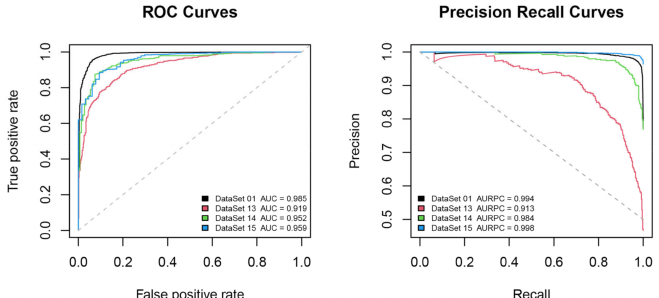
Figure 11. Recall-precision and ROC curves displaying the performance of LightGBM on testing datasets of DataSet 01, DataSet 13, DataSet 14 and DataSet 15. Note that the scale of values on the vertical axis is di ff erent from recall-precision curves (0.5–1.) and ROC curves (0.–1.).